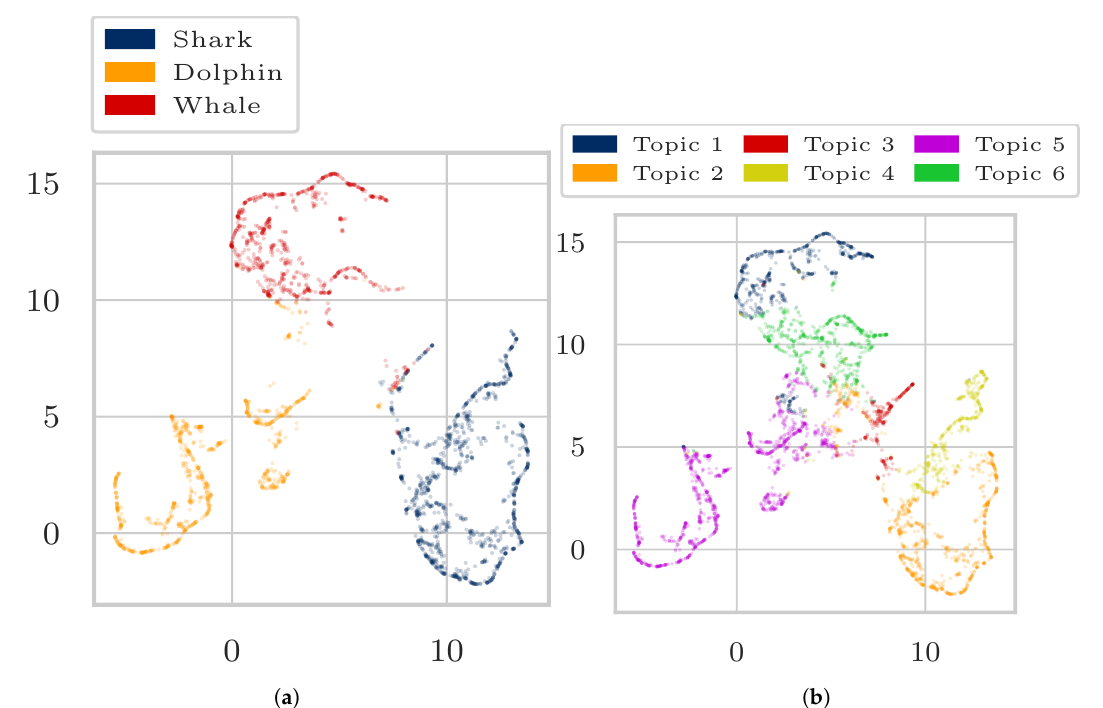
Figure A10. ( a ) 2-dimensional representation of word embeddings H colored by topic assignment. ( b ) 2-dimensional representation of word embeddings H colored by original Wikipedia article assignment (words that occur in more than one article are excluded).